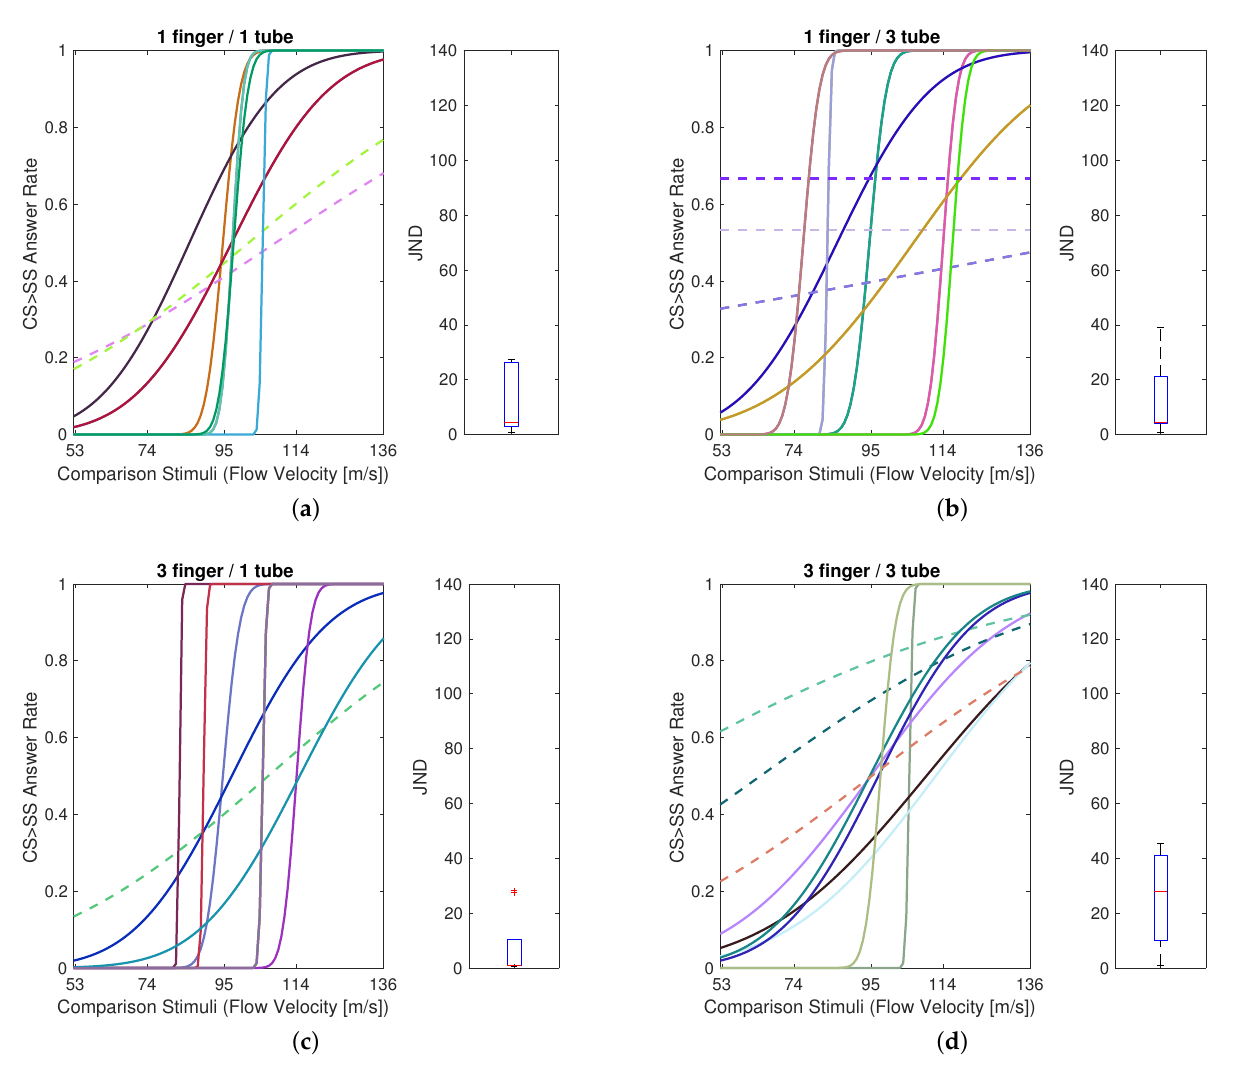
Figure 10. The probability of the subjects responding that the “comparison is stronger” with respect to the standard stimuli from the psycho-physical evaluation results (CS = comparison stimuli, SS = standard stimuli). ( a ) 1F/1T ( b ) 1F/3T ( c ) 3F/1T ( d )